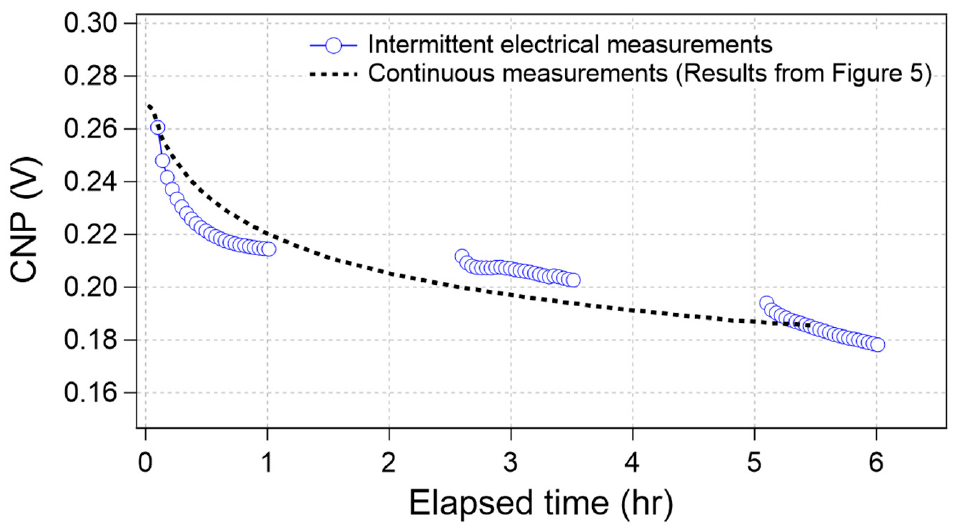
Figure 6. Time-course of the CNP value during intermittent electrical measurements (blue circle) and continuous measurements (results from Figure 5, black broken line).